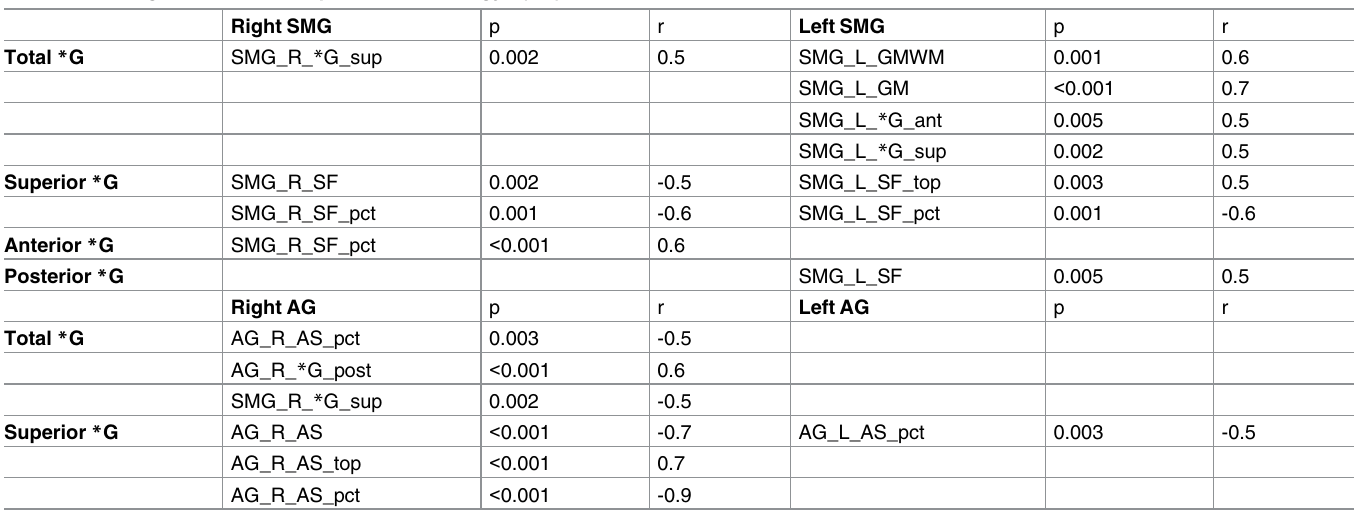
< 0.001 Relationships between the morphological characteristics and other variables listed in Tables 1 and 2. Spearman’s correlations. G * : number of additional gyri; p: p value (Spearman correlations); r: rank correlation coefficient.